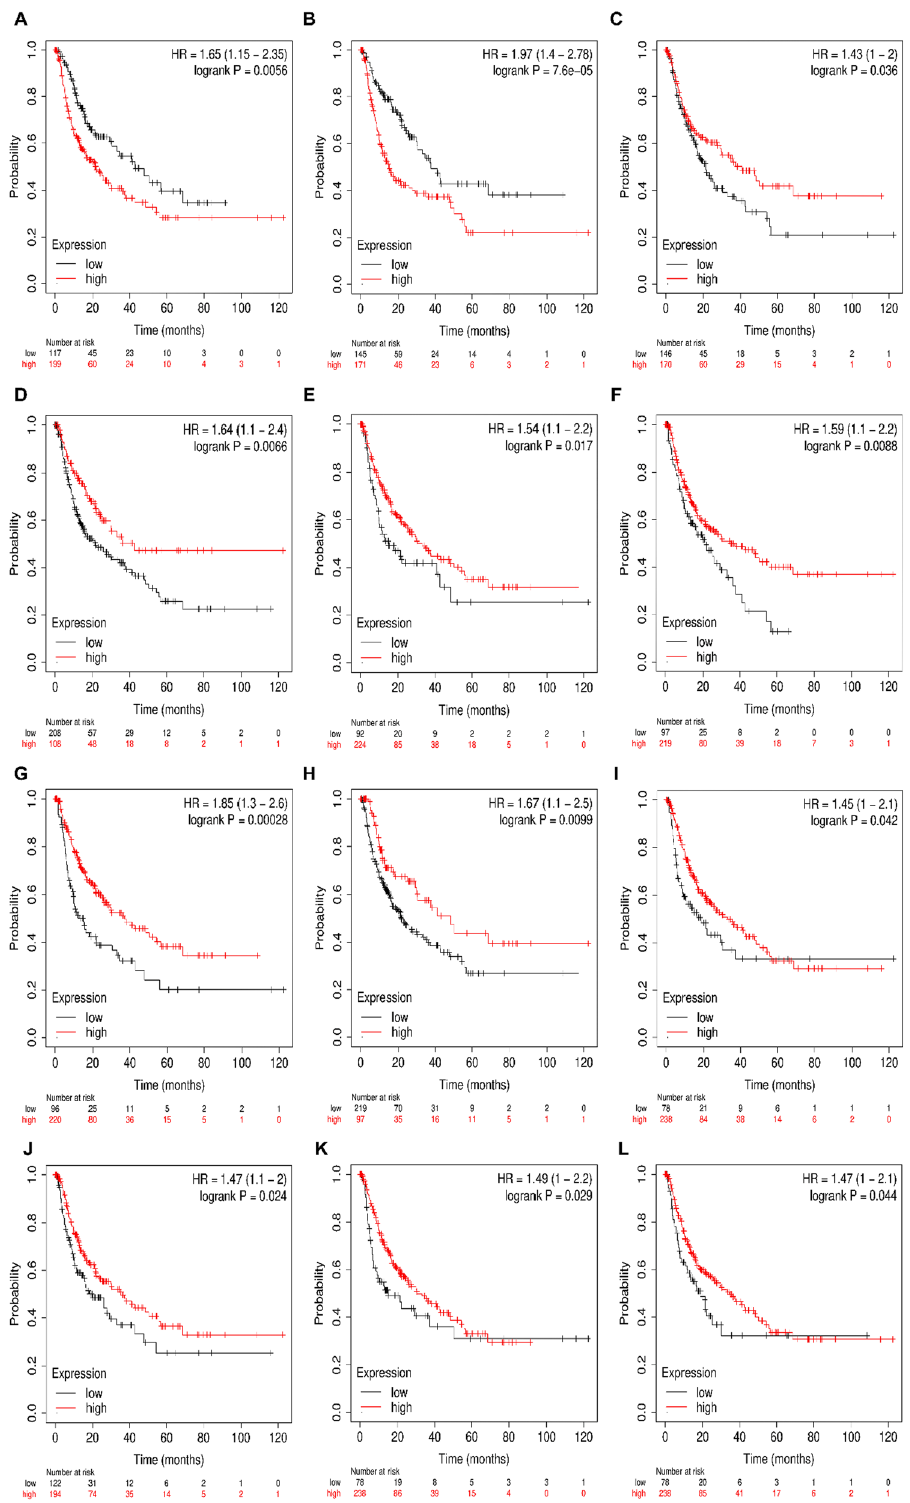
Fig. 3 KM plots showing the RFS of A APLN, B E2F1, C SFRP5, D ACADL, E ALDH2, F CNTFR, G CYP26A1, H EGR2, I GADD45B, J LIFR, K PCK1, L PTGIS across TCGA-HCC cohort. Higher and lower expression groups are signified by red and black